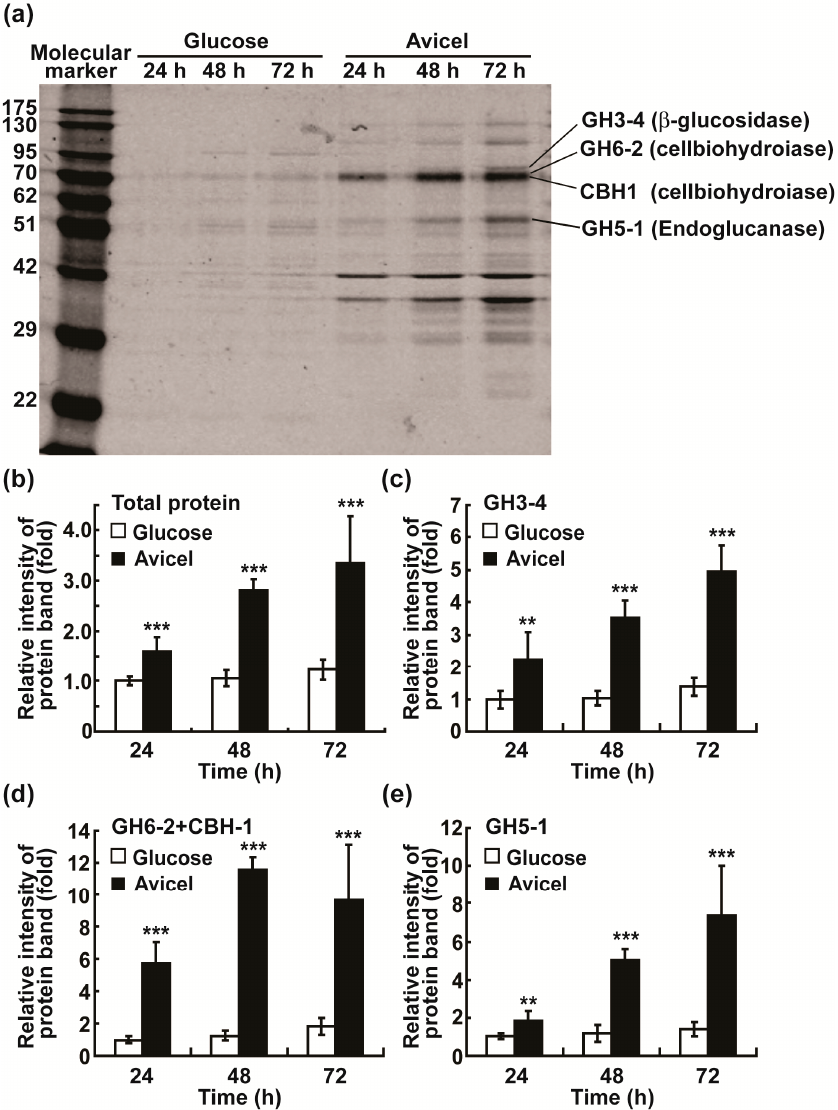
Figure 2. Analysis of secreted cellulolytic enzymes in media after 24, 48, and 72 h. ( a ) SDS-PAGE of secreted proteins in media. The gel was stained with Coomassie Blue R-250. Bands corresponding to four cellulolytic enzymes are indicated. ( b – e ) The band intensity of cellulolytic enzymes quantified using the ImageJ software (National Institute of Health, Bethesda, MD, USA). The relative intensity of the total of four enzyme bands ( b ), GH3-4 band ( c ), GH6-2 + CBH1 band ( d ) or GH5-1 band ( e ) was estimated as a ratio in band intensity compared to those in the glucose group at 24 h. Each value is the mean of six replicate measurements (three replicates per experiment and two independent experiments): ** p < 0.01, *** p < 0.001 as determined by Student’s t -test.